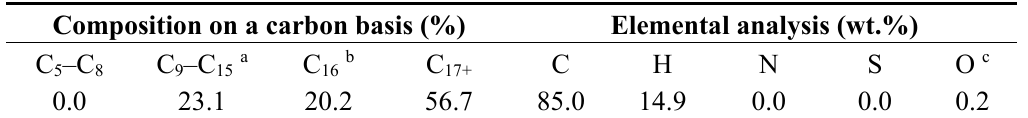
Table 5. Analytical results of FT